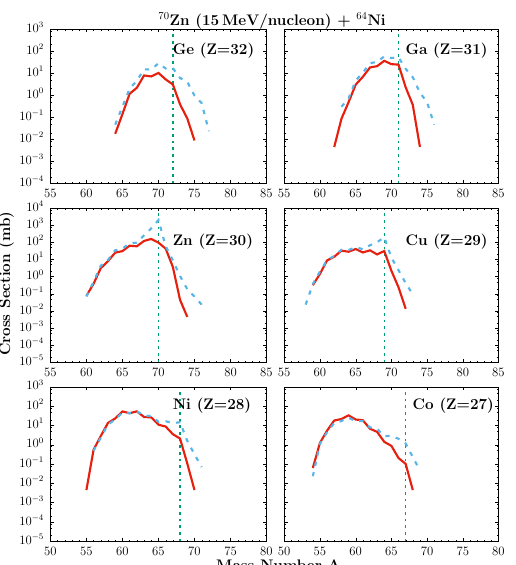
Figure 1. (Color online) Calculated mass distributions (lines) of projectile fragments with Z = 27–32 from the reaction of 70 Zn (15 MeV / nucleon) with 64 Ni. The calculations shown are: DIT / GEMINI (solid red line), CoMD / GEMINI (dashed blue line). The green vertical line indicates the starting point of neutron pickup.